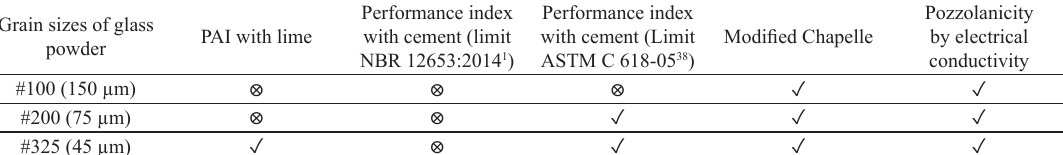
Table 6. Summary of the results of the pozzolanic activity tests performed with glass powder. Grain sizes of glass powder